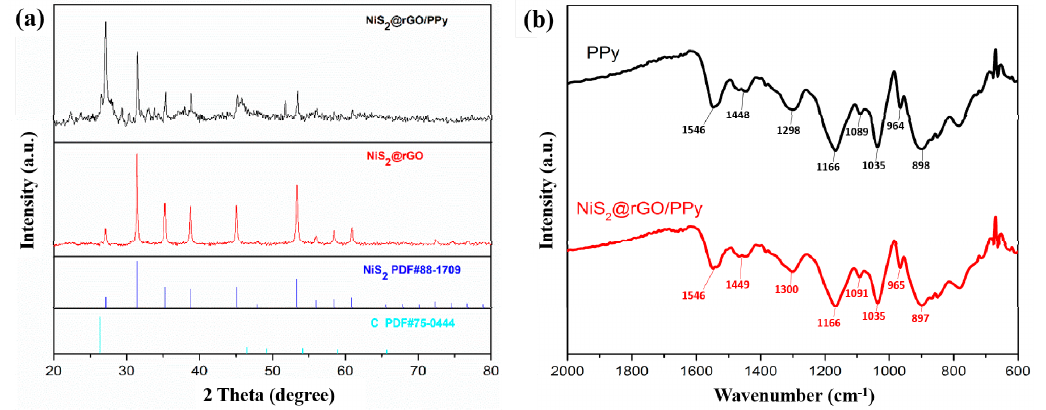
Figure 1. ( a ) X-ray diffraction (XRD) patterns of the NiS 2 @rGO/PPy ternary composite and the NiS 2 @rGO binary composite; ( b ) Fourier transform infrared (FT-IR) spectra of the PPy and NiS 2 @rGO/PPy ternary composites.